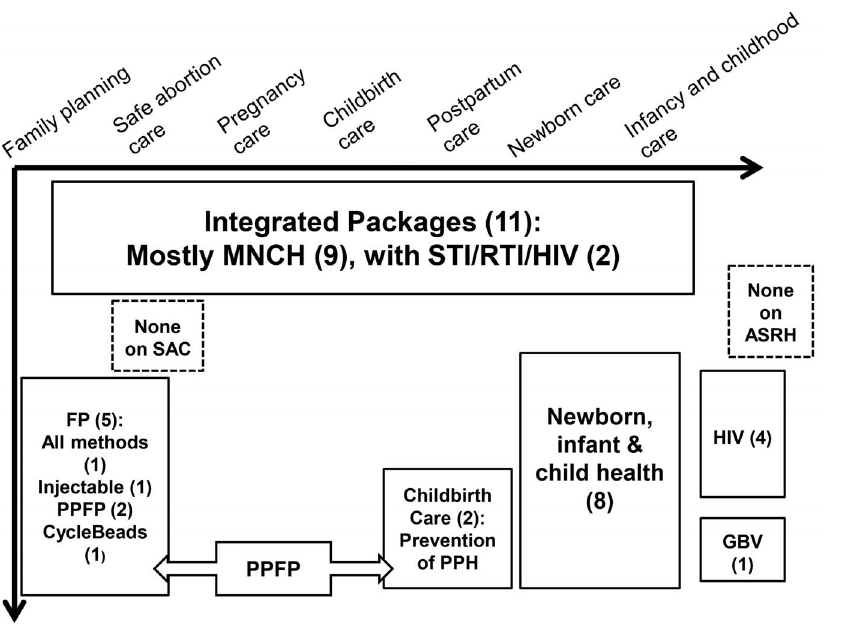
Figure 3. Distribution of identified training resource packages. By breadth (x axis) and depth (y axis) of coverage along the continuum of sexual and reproductive health and maternal, newborn, child, and adolescent health continuum (n=number of packages). Acronyms: ASRH: adolescent sexual and reproductive health, FP: family planning, GBV: gender-based violence, MNCH: maternal, newborn and child health, NB: newborn, PPFP: postpartum family planning, PPH: postpartum haemorrhage, RTI: reproductive tract infection, SAC: safe abortion care, STI: sexually transmitted infection.